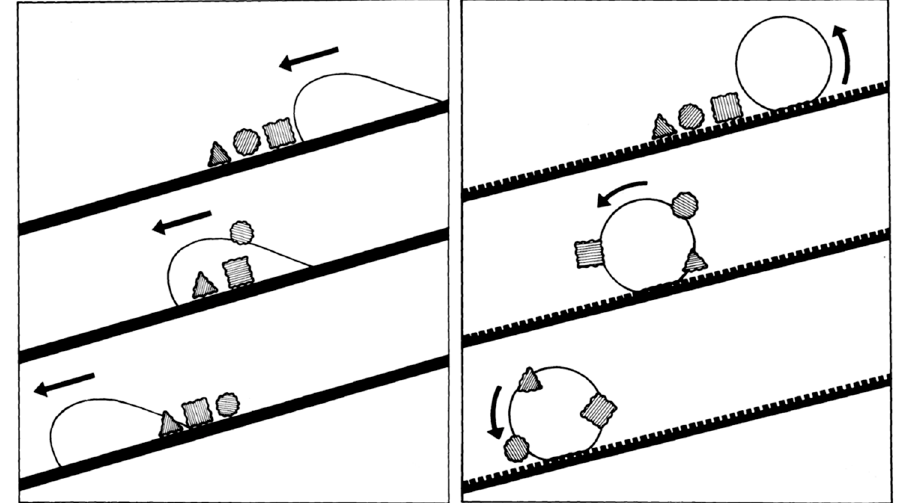
Figure 5. Schematic illustration of the working mechanism of the self-cleaning effect. Reprinted with permission from [26], Copyright (1997) Springer.